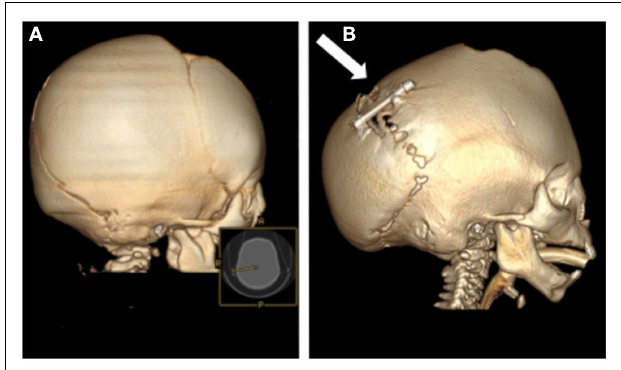
FIGURE 3 | Computed tomography scans of an infant with multiple suture synostosis preoperatively (A) and 4months after distraction of the posterior cranial vault (B). The distraction footplates have been gradually separated by a distance of 25mm and evidence of calcified bony regenerate is present between the footplates